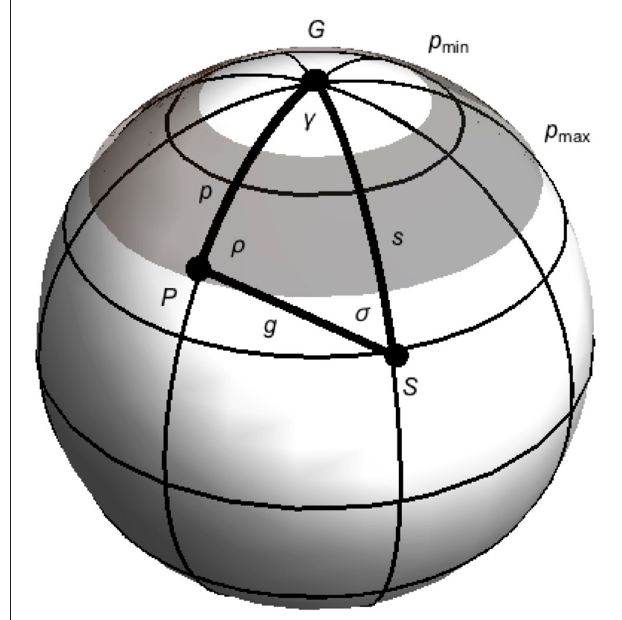
FIGURE 1 | Schematic diagram showing the relationship between the geographic pole position G, a dipole pole position P and a sampling locality S . The three positions are connected by three great-circle arc-lengths p, s and g at angles ρ , γ , and σ as shown. Note the break from the standard naming convention for a triangle. The limits p max and p min are shown, with a corresponding integration surface for Equation (3) in gray.